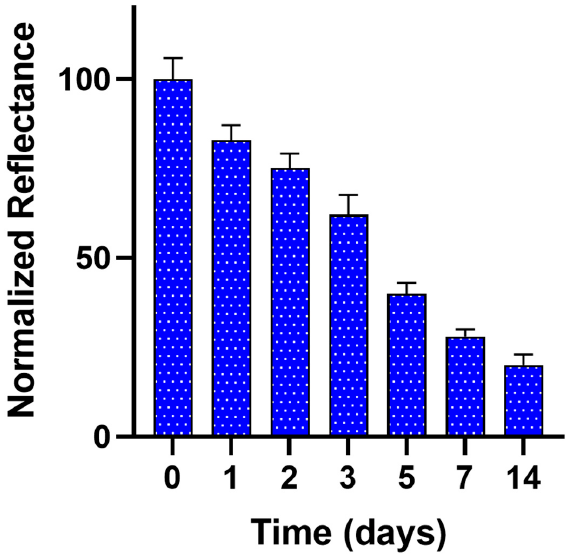
Figure 4. Stability of the BA sensing paper stored at +4 °C. For each measurement, three sensing papers were tested following the procedure reported in Section 2.7. Colorimetric measurements were obtained with a OnePlus 6T and analyzed with ImageJ software. Reflectance signals are normalized with respect to day 0.